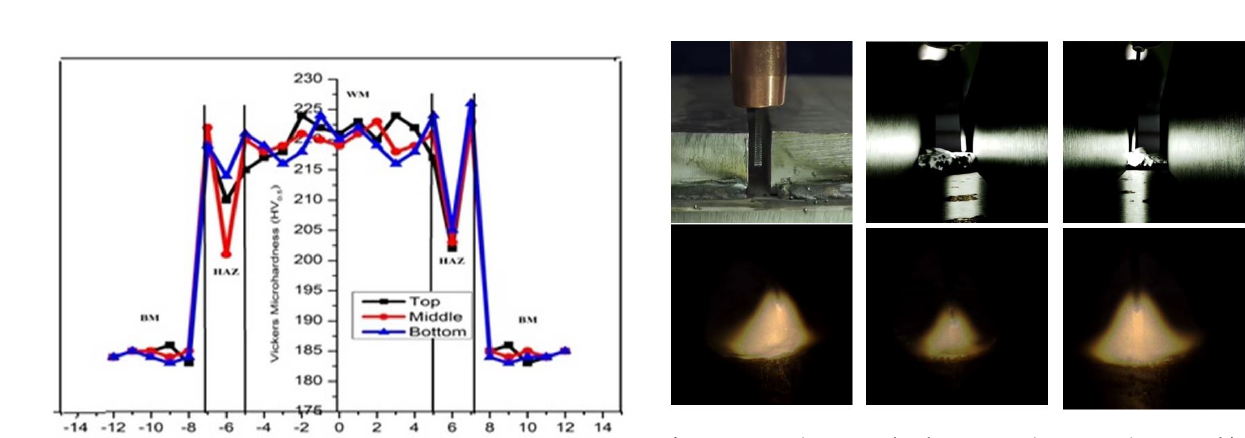
Figure 14: Rotating Arc technology; operation at rotating arc weld- ing high speed video